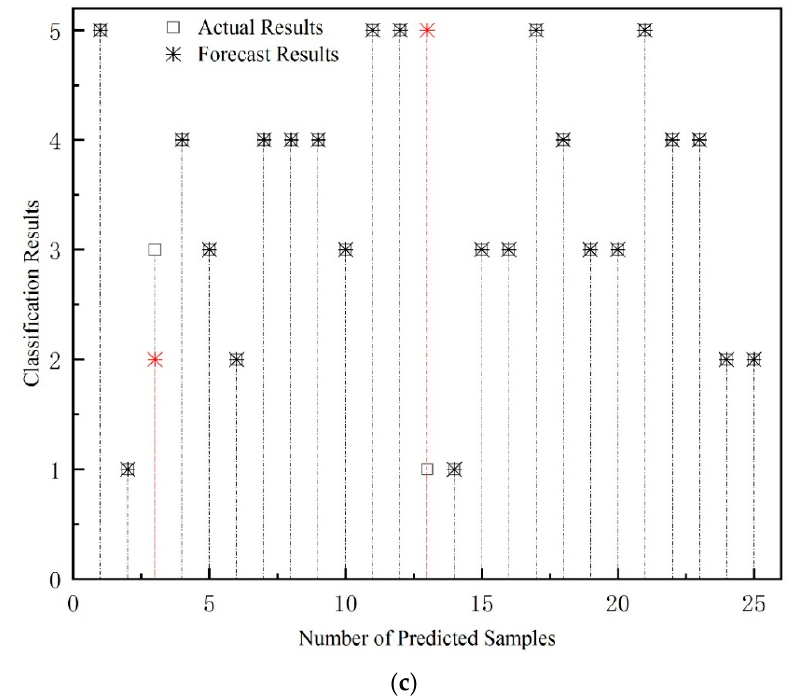
Figure 6. ( a ). The effect of 75 groups of sample data after FAST-PNN training, among them, the error is marked in red. ( b ) Error map of 75 sets of training sample data after FAST-PNN training, among them, the error sample is marked in red. ( c ) Prediction effect diagram of 25 groups of prediction samples from FAST-PNN, among them, the error sample is marked in red.